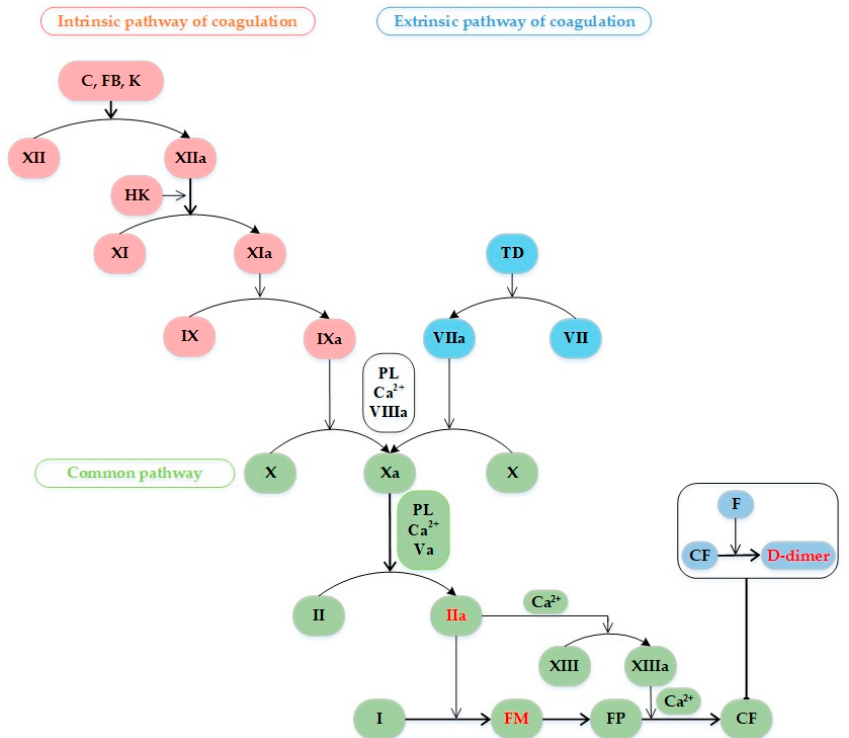
Figure 1. The extrinsic and intrinsic pathway of coagulation and the formation process of D-dimer. Abbreviations: Roman numerals, the clotting factors; C, collagen; FB, foreign body; K, kallikrein; HK, high-molecular-weight kininogen; PL, phospholipid; TD, tissue damage; FM, fibrin monomer; FP, fibrin polymer; CF, crosslinked fibrin; F, fibrinolysinum.